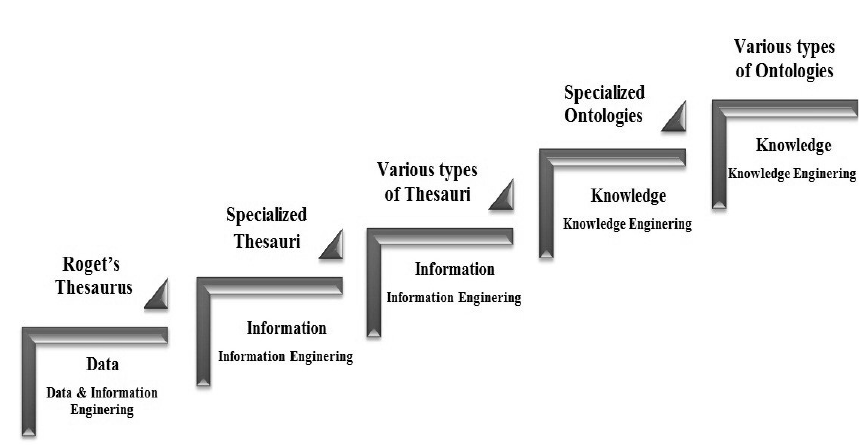
Figure 1: The Categorization of the KOSs based on "semantic staircase" (Olensky,